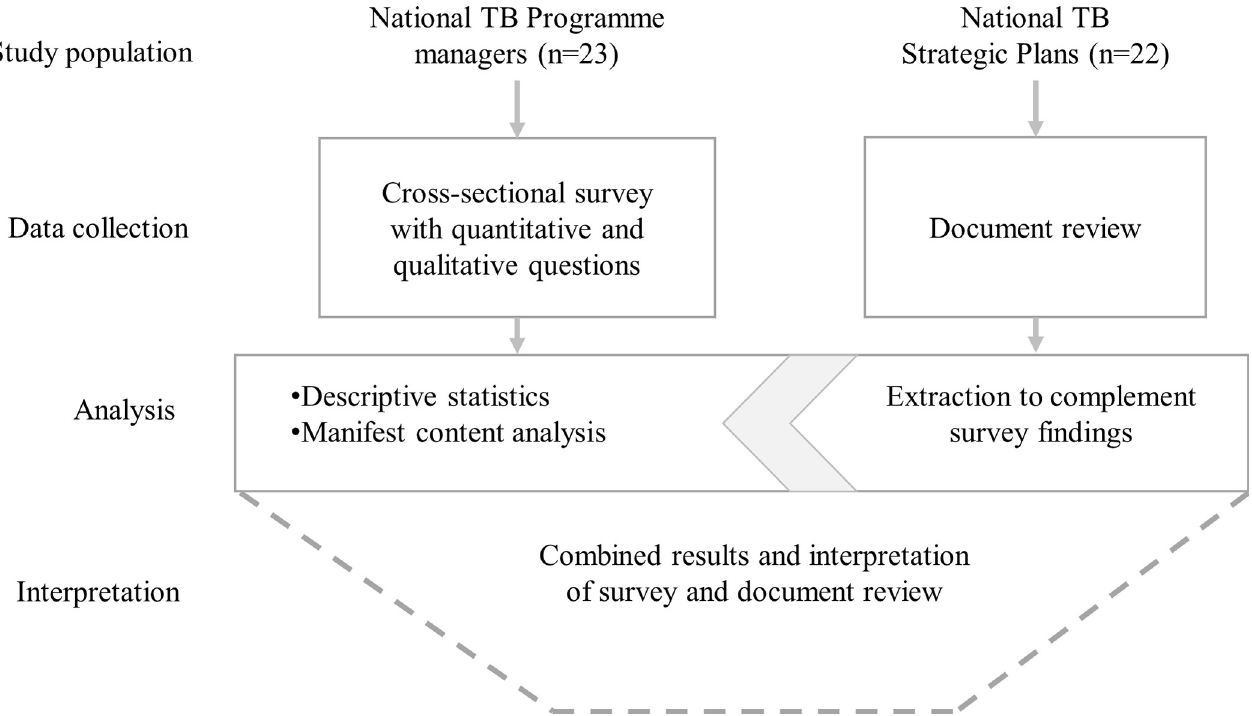
Fig 1. Pictorial representation of the data collection steps, analysis and interpretation. 23 National Tuberculosis (TB) Programme managers participated in the cross-sectional survey, which was analyzed using descriptive statistics and manifest content analysis. 22 National TB Strategic Plans were reviewed, and data extracted to complement the survey findings. All data were analyzed in parallel and merged in the interpretation of the findings.